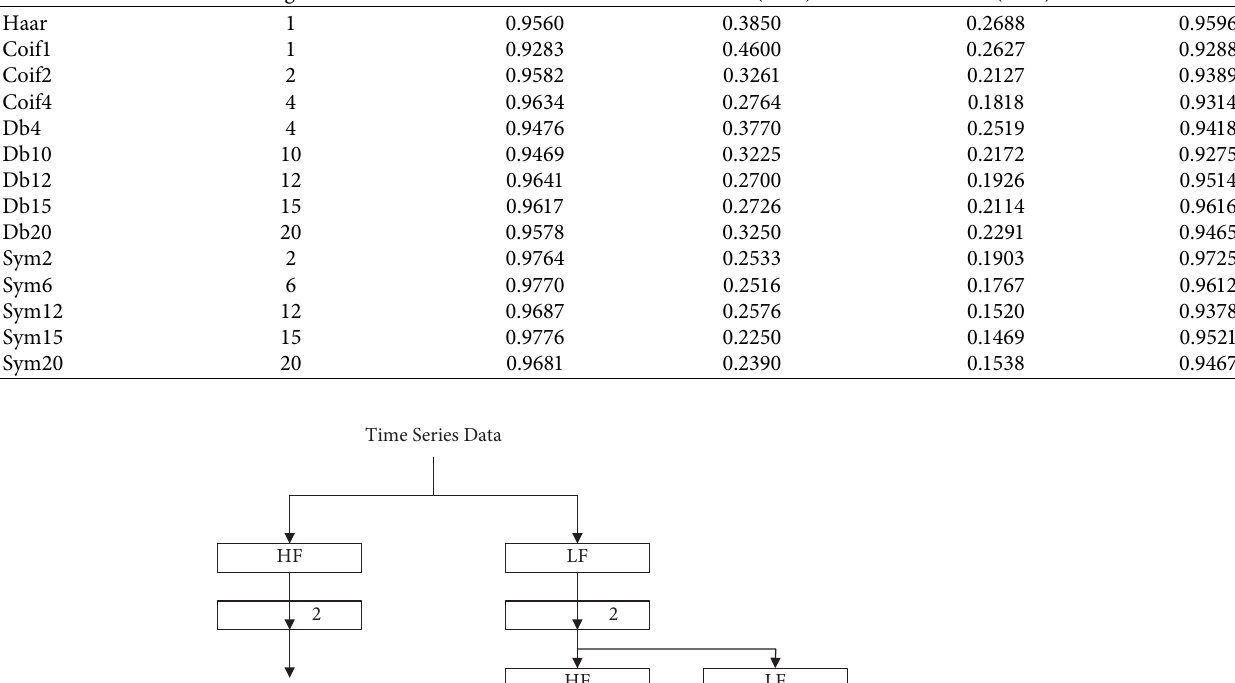
Table 3: Performance of various WFORS models with diferent mother wavelet functions.